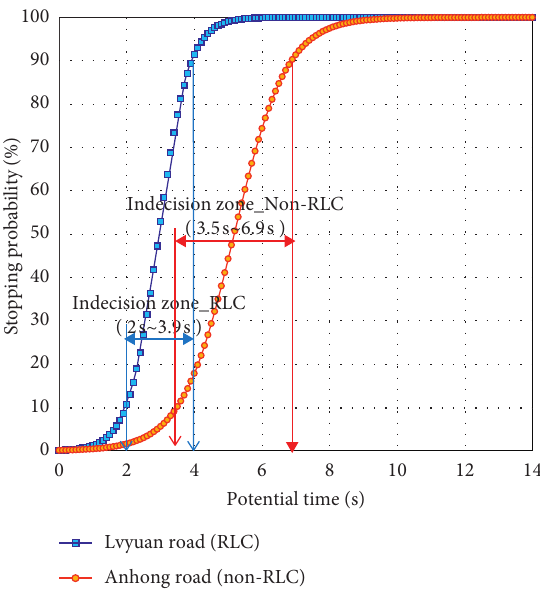
Figure 6: Indecision zones of the RLC intersection and the non- RLC